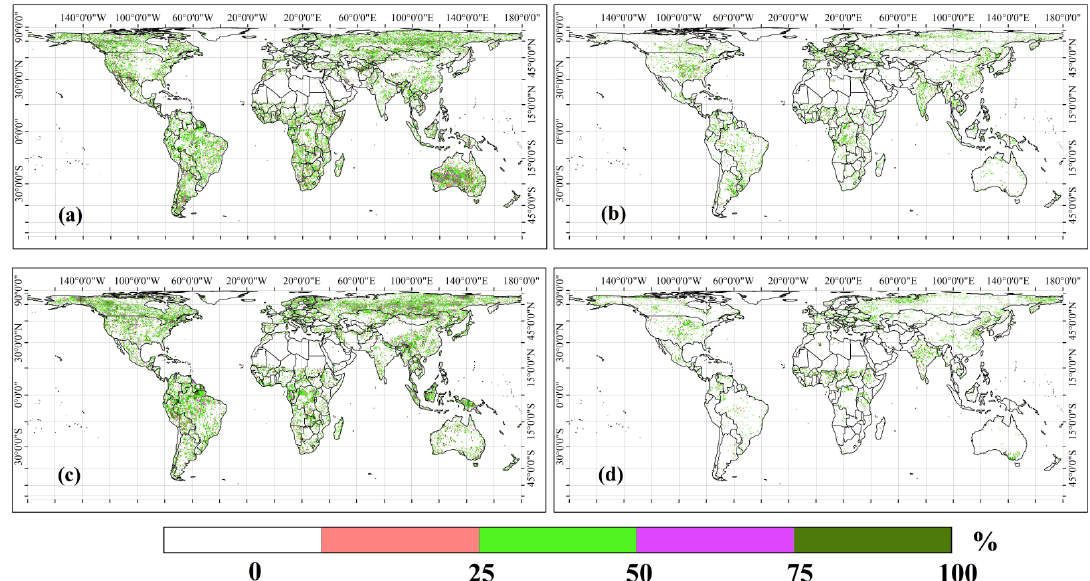
Figure 6. Spatial distribution of the probabilities of concurrence positive extremes of CUE with ( a ) positive extremes of GPP and ( b ) negative extremes of Ra. Negative CUE extremes with ( c ) negative extremes of GPP and ( d ) positive extremes of Ra.